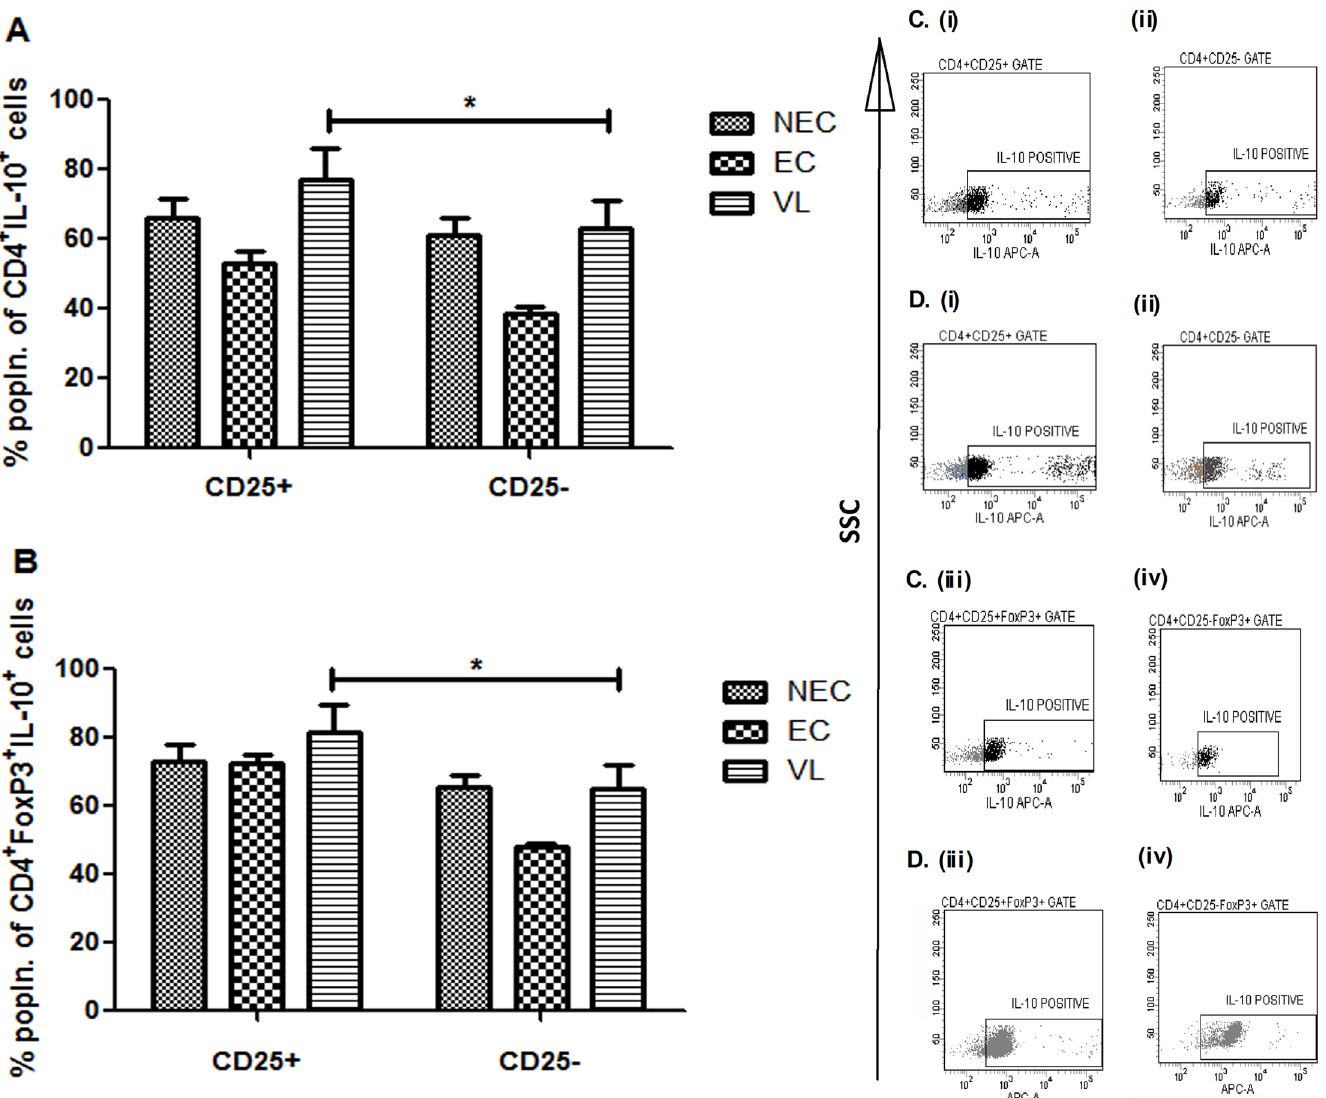
Fig 6. Identification of cellular sources of IL-10 in PBMCs of VL patients (n = 10), ECs (n = 5) and NECs (n = 5). Total PBMCs were freshly cultured in the presence of PMA (50 ng/ μ l), ionomycin (1 μ g/ μ l) for 2 hrs and for additional 1 hr in presence of brefeldin A (10 μ g/ μ l) before staining. (A) Percentages of CD25+ and CD25 − cells among CD4+IL-10+ cells. (B) Percentages of CD25+ and CD25 − cells among CD4+FoxP3+IL-10+ cells. Data are represented as mean ± SE. P values were calculated using Wilcoxon matched pairs signed rank test for paired samples; P < 0.05 was considered significant. (C), (i)-(iv) Data showing one representative healthy control. (D), (i)-(iv) Data showing one representative active VL